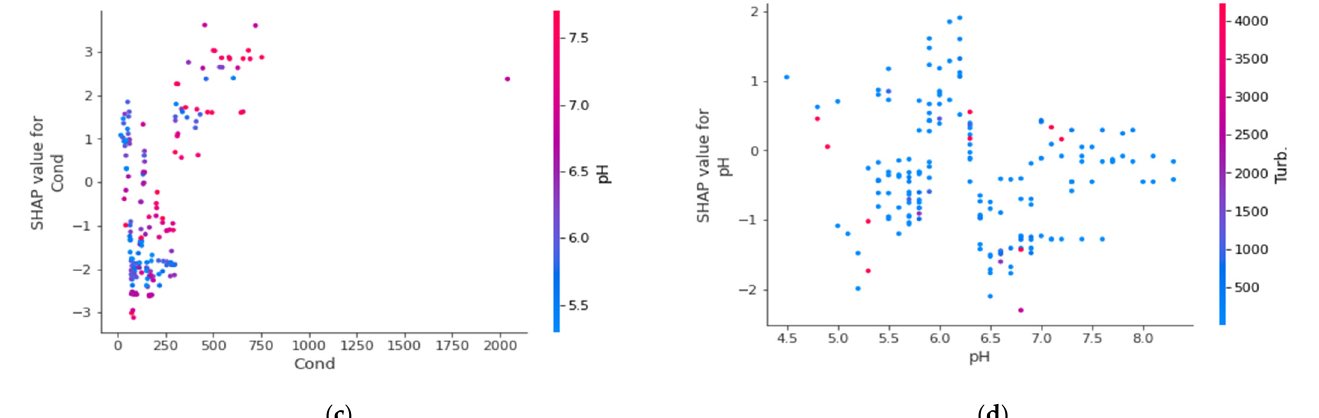
Figure 10. SHAP dependency and interaction effect plots for medium As concentrations: ( a ) TDS; ( b ) Turb; ( c ) Cond; and ( d ) pH.